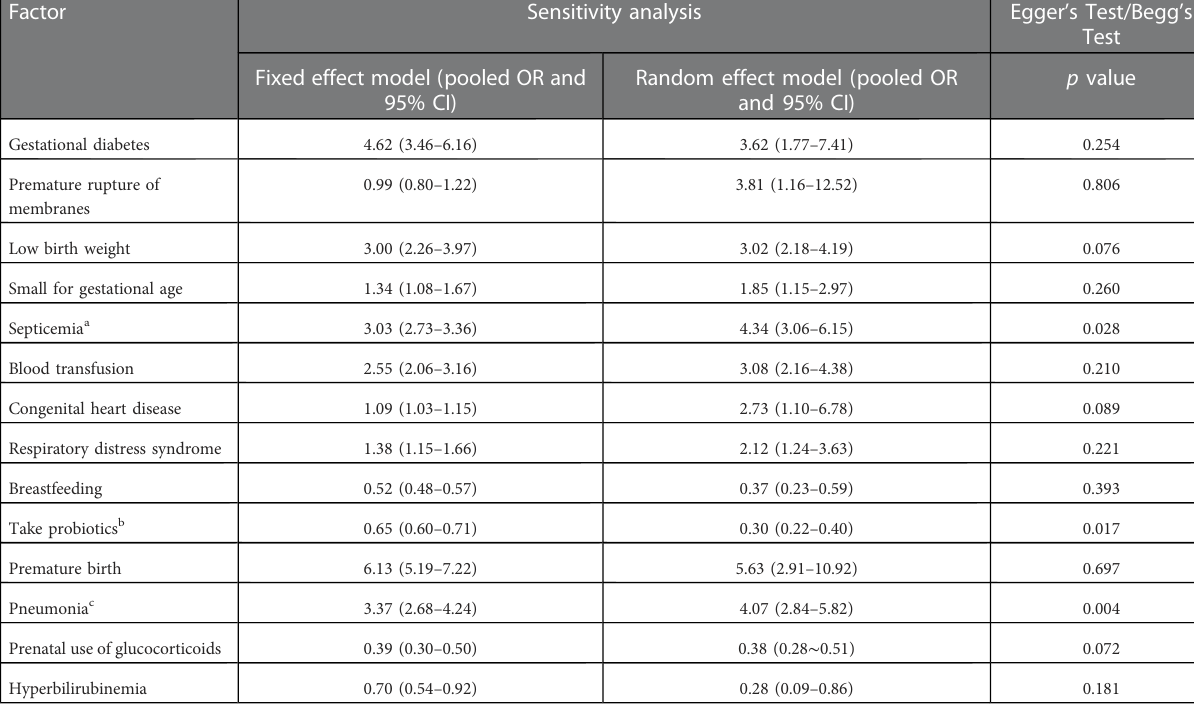
TABLE 3 Sensitivity analysis and bias